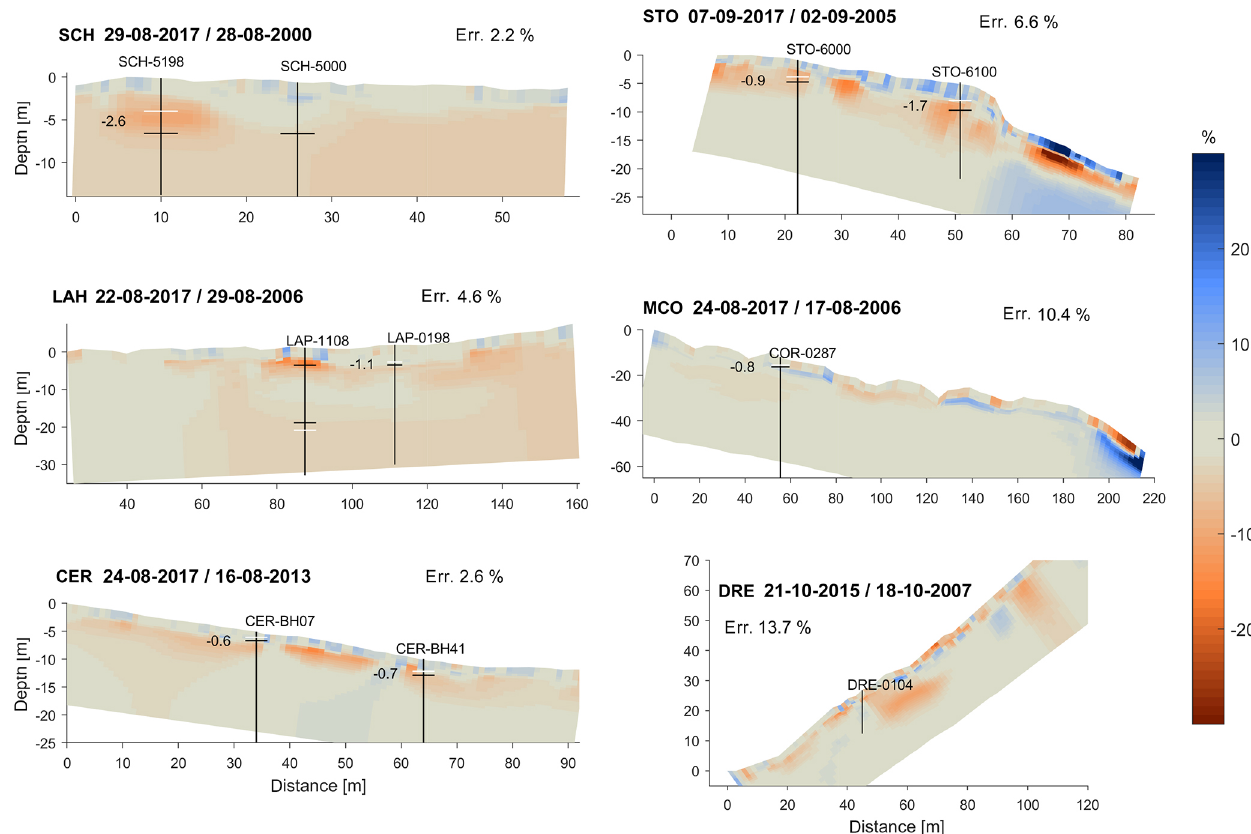
Figure 7. Percentage change of resistivity logarithm over the full observation period for comparable dates at end of summer for each site. Vertical lines represent borehole positions and horizontal lines the thaw depth (white and black lines correspond to the oldest and most recent dates, respectively). Change in ALT is expressed in metres near the boreholes. Missing white lines (for SCH and LAH) correspond to non-existent